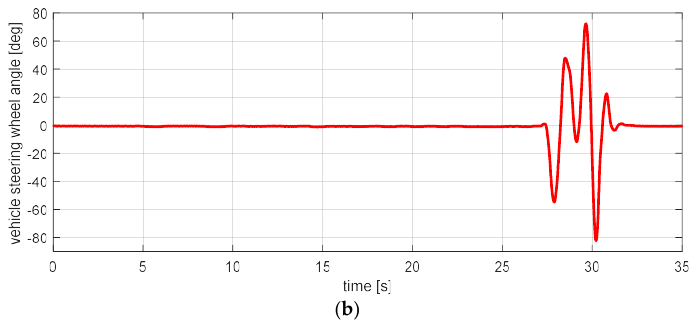
Figure 6. Estimation simulation scenario 1. ( a ) Vehicle speed; ( b ) steering wheel angle.